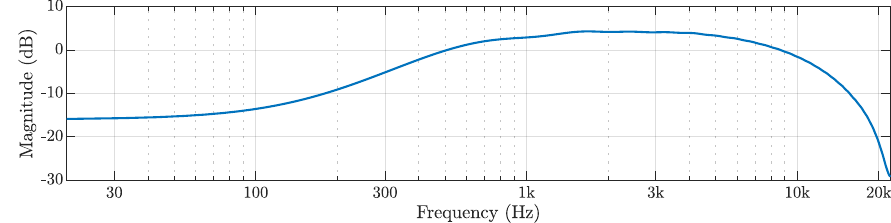
Figure 11. The frequency response of the low-passed A-weighting pre-emphasis filter.